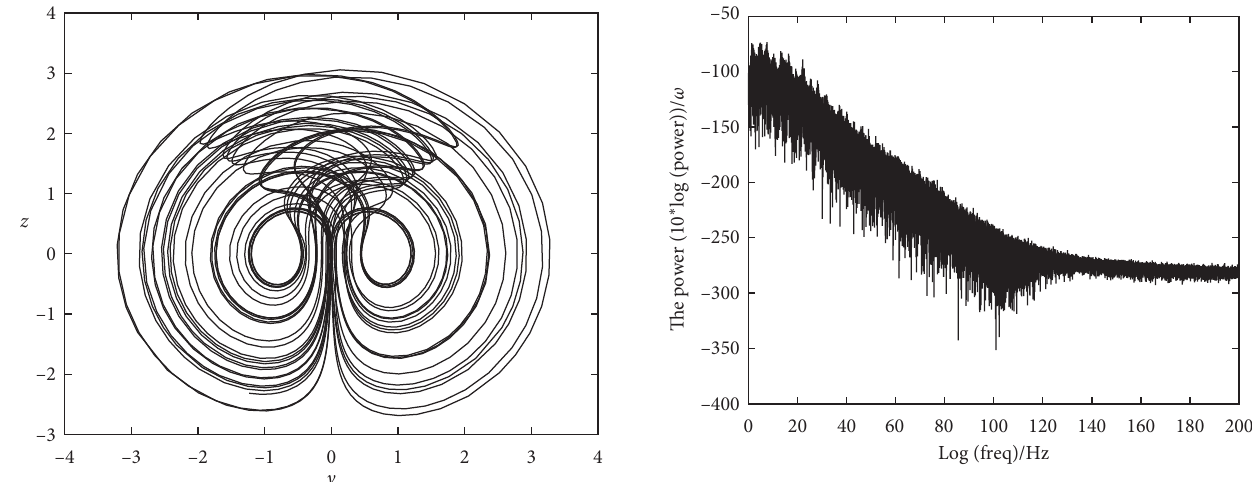
Figure 4: y - z phase plane of the chaotic attractor.